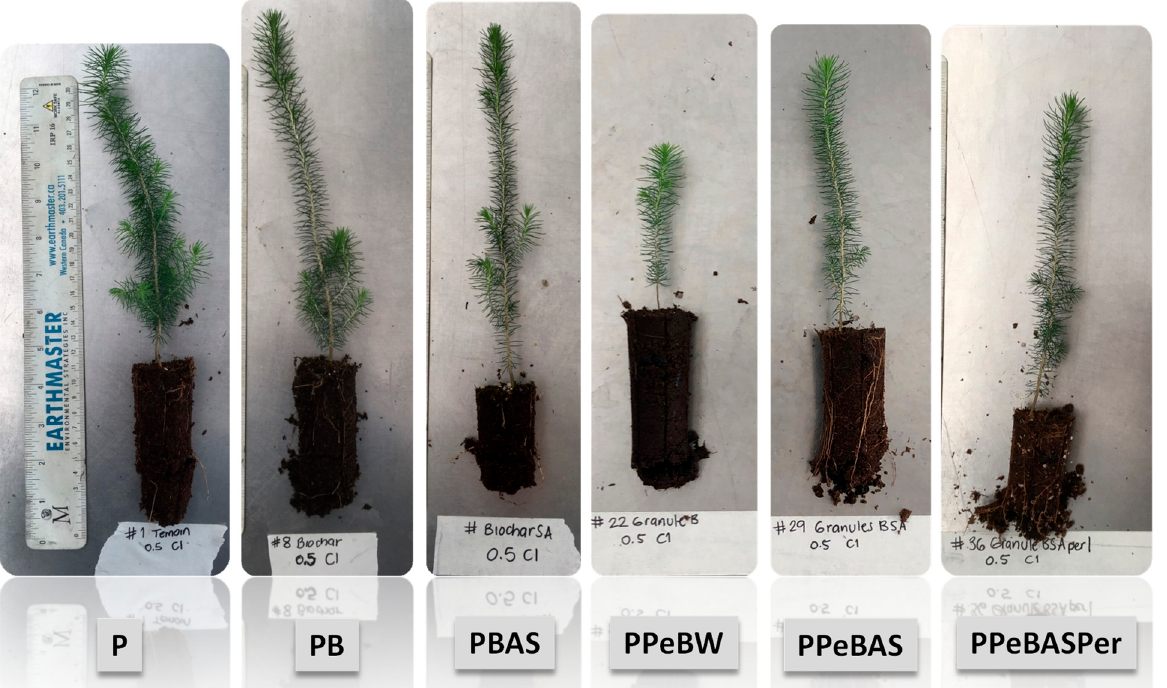
Figure 2. The final experiment of Black spruce growth on the different substrates for 23 weeks in the greenhouse: 100% peat (P), 75% peat plus 25% bulk biochar (PB), 75% peat plus 25% bulk biochar impregnated with ammonium sulfate (PBAS), 75% peat plus 25% biochar pellets with water (PPeBW), 75% peat plus 25% biochar pellets with ammonium sulfate (PPeBAS) and 62.5% peat plus 25% biochar pellets with ammonium sulfate plus 12.5% perlite (PPeBASPer).